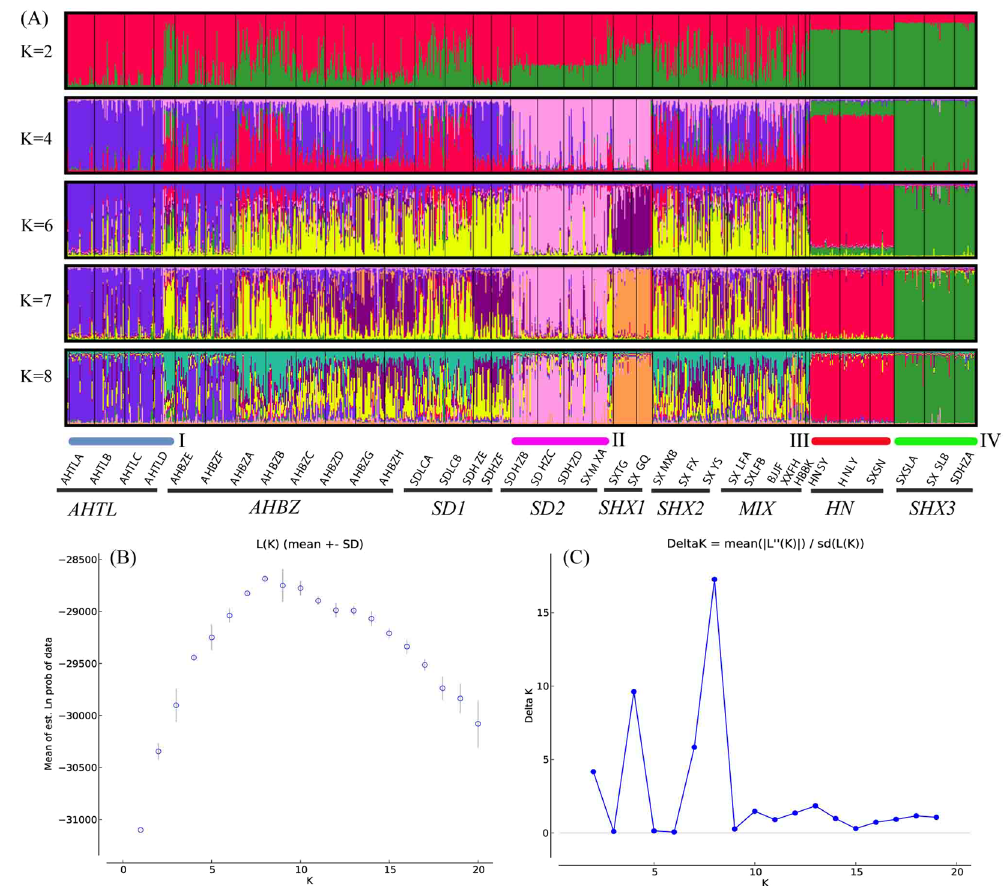
Figure 2. ( A ) Estimated population structure and clustering of the 901 P. ostii individuals with K = 2 to 8 (except K = 5). ( B ) Values of L( K ) obtained in the STRUCTURE analyses. ( C ) Δ K estimates of the posterior probability distribution of the data for a given K